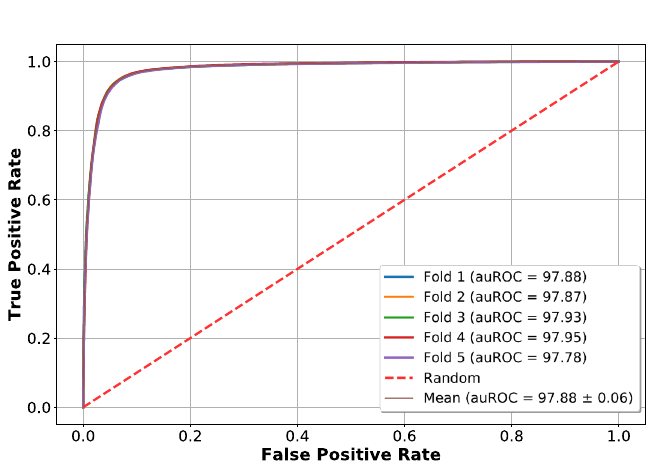
Figure 4. Fivefold cross validation ROC curves on benchmark